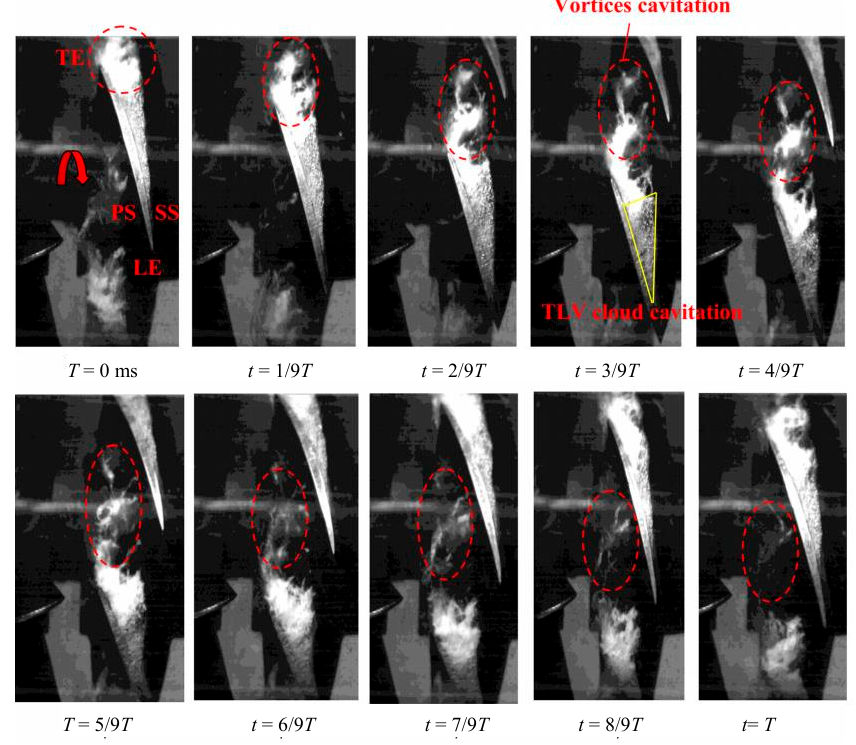
Figure 12. TLV cloud cavitation in an axial flow pump at σ = 0.262 [8].